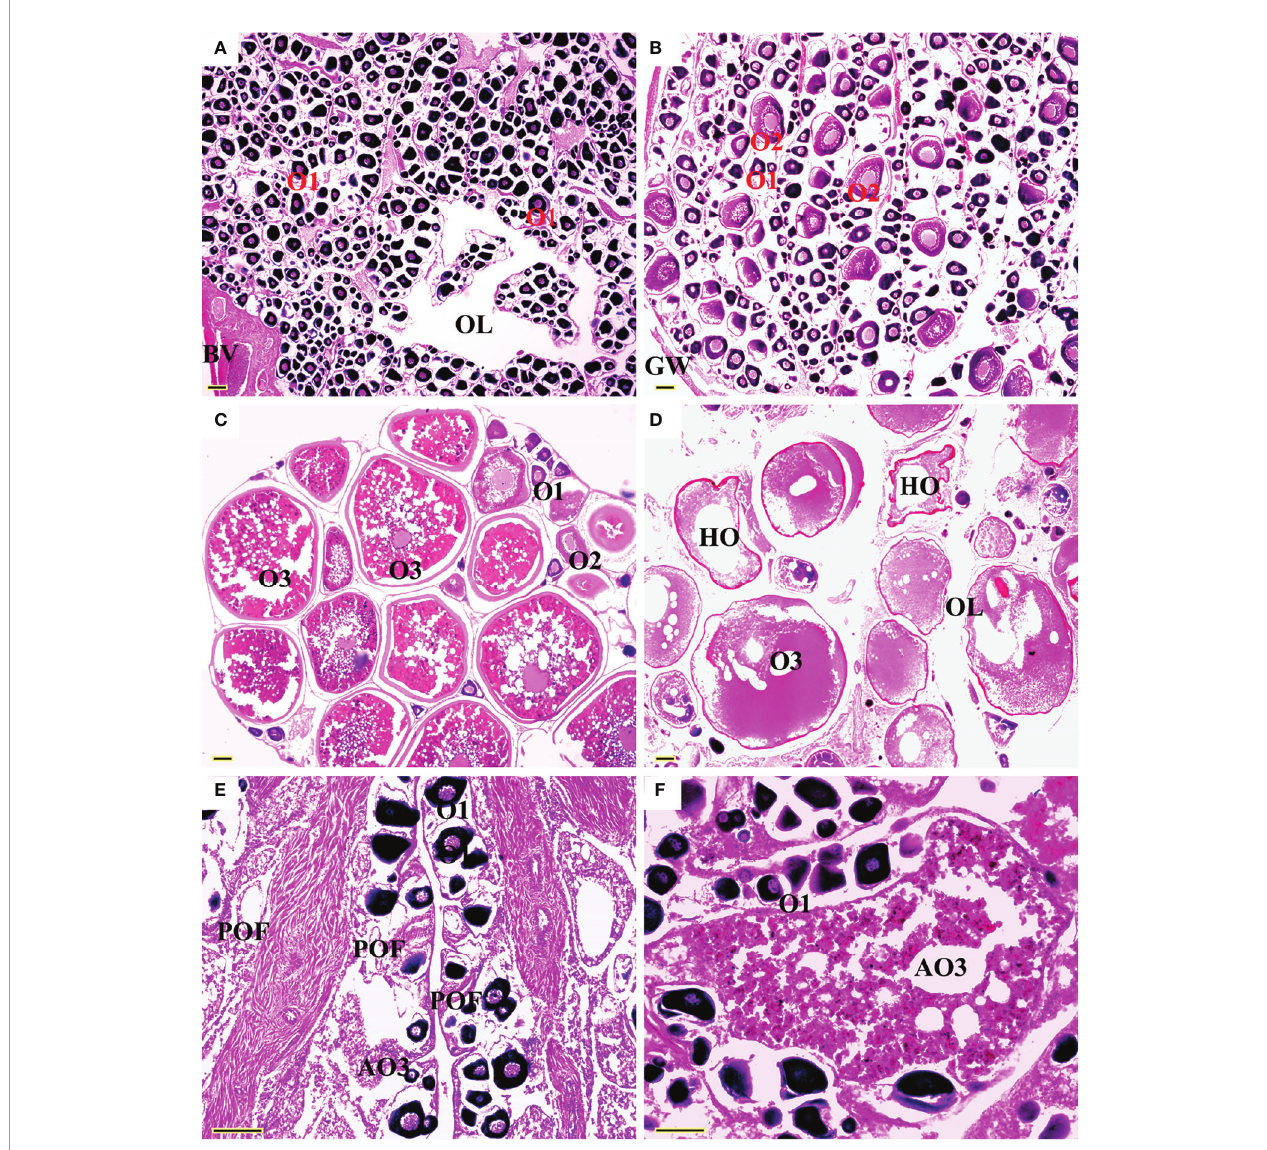
FIGURE 5 | Sexual maturity stages in females of Larimichthys crocea . (A) F1: Immature/resting (175 mm SL, July 2021); (B) F2: Developing (212 mm SL, April 2021); (C) F3: Maturing (249 mm SL, June 2020); (D) F4: Ripe (198 mm SL, May 2019); (E) F5: Spent (212 mm SL, June 2021); (F) F5: Spent (360 mm SL, June 2021). AO3, atretic vitellogenic stage oocyte; BV, blood vessels; GW, gonadal wall; HO, hydrated oocyte; O1, primary growth stage oocyte; O2, cortical-alveolar stage oocyte; O3, vitellogenic stage oocyte; OL, ovarian lumen; POF, post-ovulatory follicles. Scale bars: 100 m